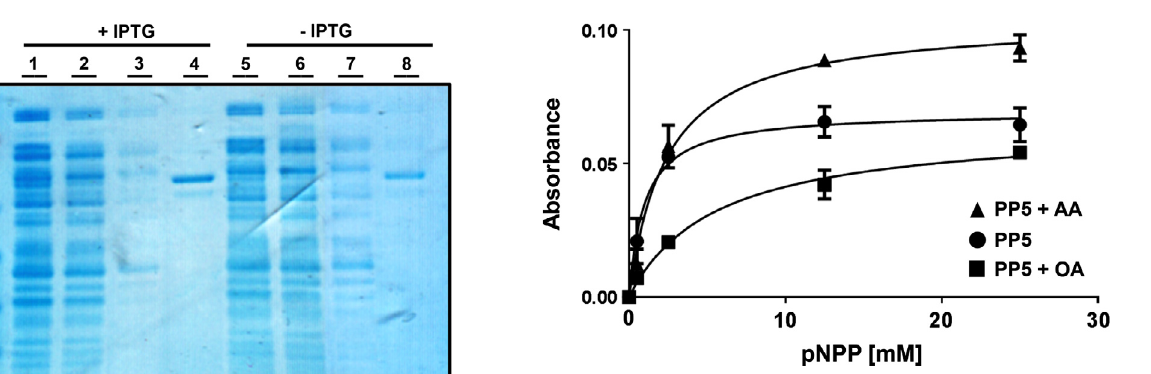
Figure 4. Catalytic activity. PP5 activity was assessed at increasing pNPP substrate concentrations [ d ] in the presence of 5 l M AA [ m ] or 25 l M OA [ n ] and absorbance was measured on a plate reader at 405 nm. A dose-dependent non-linear regression curve was gener- ated and standard deviation is shown ( n =